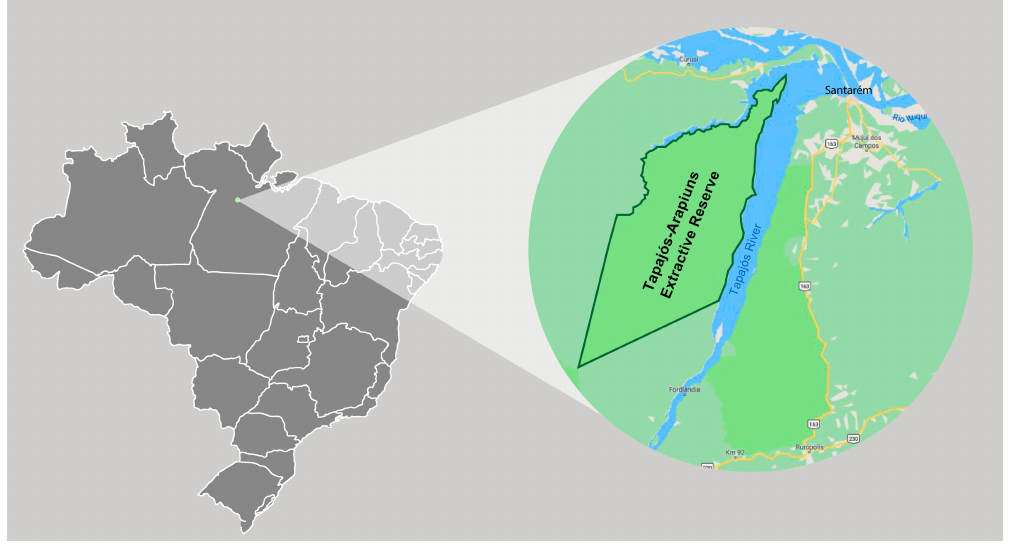
Figure 2. Location of the Tapajós-Arapiuns Extractive Reserve in the state of